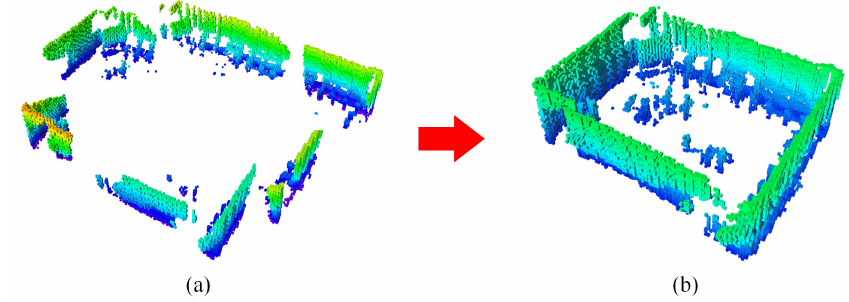
Figure 6. An illustration of the OctoMap construction. ( a ) sub-OctoMaps, ( b ) full